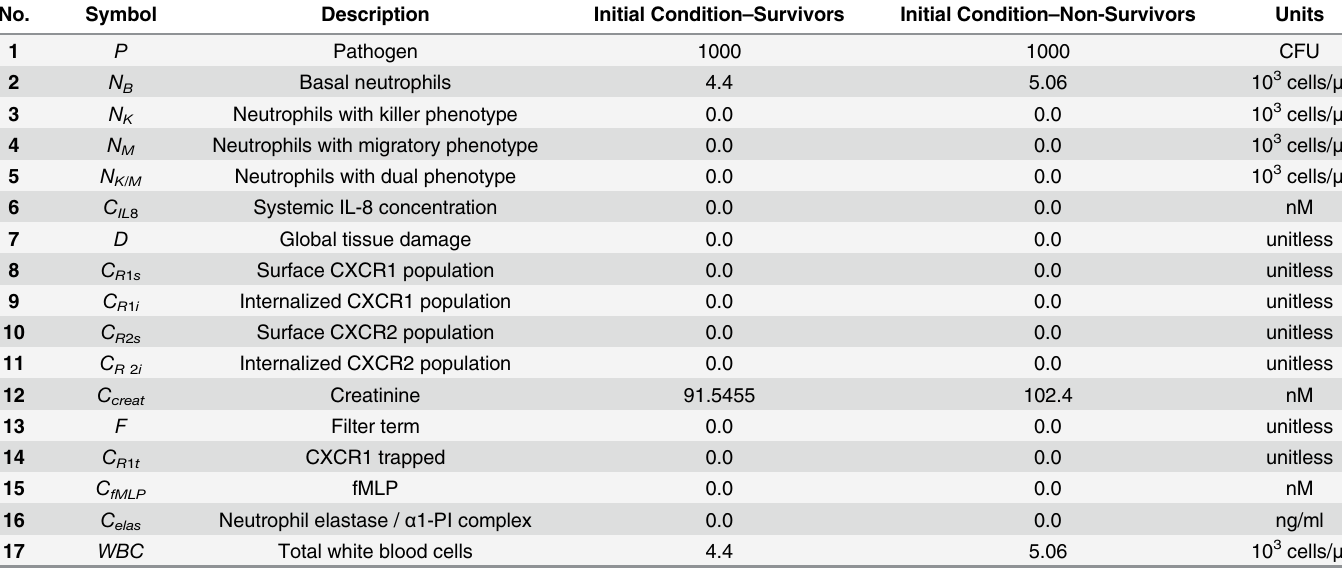
Table 1. Initial